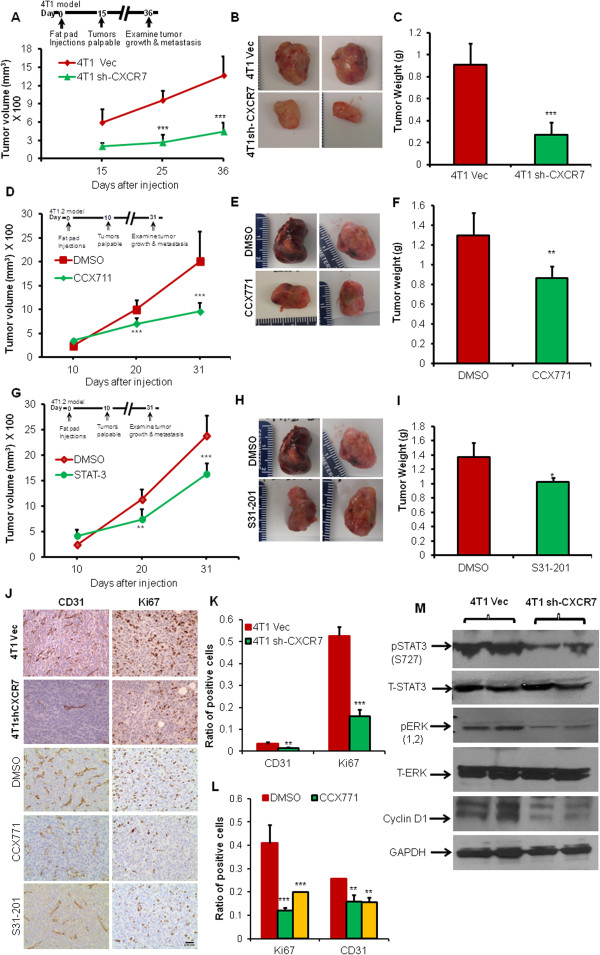
CXCR7 regulates breast cancer tumor growth in vivo by regulating angiogenic, proliferative, and signaling pathways. Female BALB/c mice (6 to 8 weeks old, n = 5) were anesthetized and injected with 2.5 x 105 breast cancer cells 4T1 Vec and 4T1 sh-CXCR7 (downregulated for CXCR7). (A) Tumors were measured by digital calipers weekly for 36 days (mice model inset). (B) Representative photographs of tumors, 36 days after the injection of cells. (C) Tumor weight after 36 days. Female BALB/c mice (6 to 8 weeks old) were anesthetized and injected with 1 × 105 viable 4T1.2 cells into the fourth mammary fat pad. Mice were divided into three groups of five mice each and were injected intraperitoneally with either DMSO or CXCR7 inhibitor (CCX771) or STAT3 inhibitor (S31-201) at 5 mg/kg body weight 3 times a week for 21 days (inhibitors were injected in mice after tumors were palpable), (D, G) tumors were measured with digital calipers (mice model inset) (E, H) Representative photographs of tumors, 31 days after the injection of cells. (F, I) Tumor weight after 31 days. (J) 4T1 Vec, 4T1 sh-CXCR7, and 4T1.2 cell line-derived tumors from CCX771 or S31-201 treated or untreated group were subjected to immunohistochemical (40×) staining with anti-CD31 or Ki67. (K, L) The stained cells were counted in four different fields by using bright-field microscope in each experimental group and the average was calculated. Bars represent the mean ± SD of number of CD31-positive blood vessels and Ki67-positive cells to that of total cells. (M) 4T1 Vec and 4T1 sh-CXCR7 cell line-derived tumors were lysed and analyzed for Phospho STAT3, STAT3, Phospho-ERK (p-ERK), ERK, cyclin D1, and GAPDH with immunoblotting. Data represent the mean ± SD per experimental group. Scale bars, 0.03 mm. *P < 0.05, **P < 0.01, ***P < 0.001 versus control.